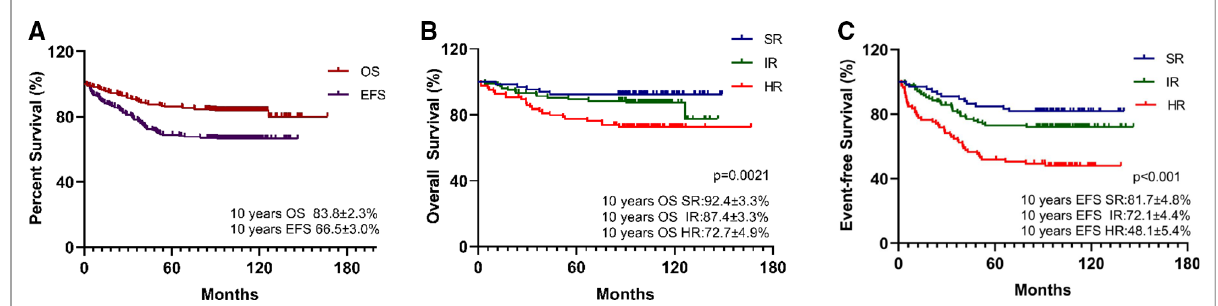
FIGURE 1 Survival analysis of pre-B-ALL treated by CCLG-2008 protocol ( A ) and the impact of risk group on long-term survival: 10-year OS ( B ), 10-year EFS ( C ), with P -values estimated by log-rank test ( P =0.0021 and P <0.001), suggesting that risk group associated with poor survival.